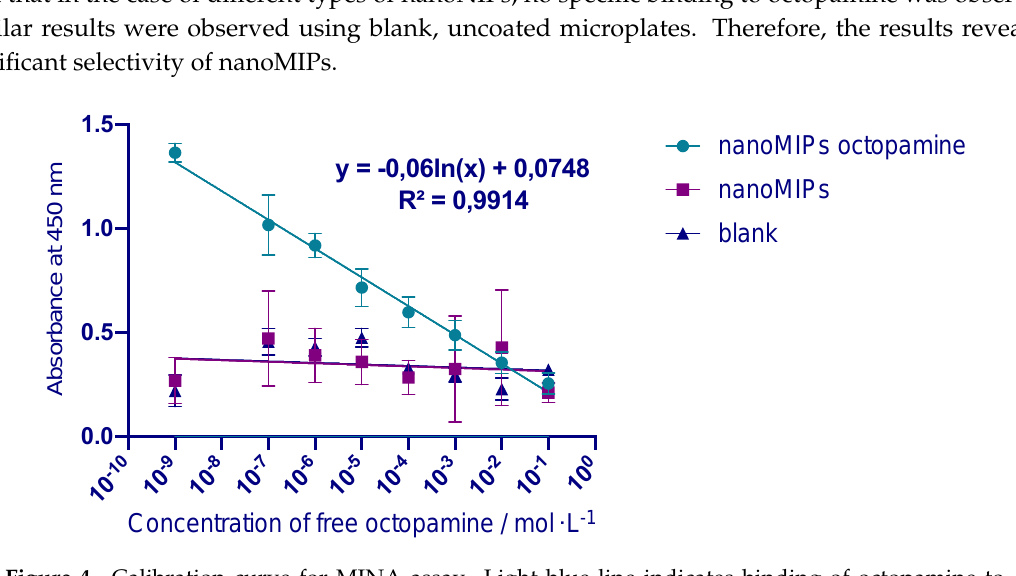
Figure 4. Calibration curve for MINA assay. Light blue line indicates binding of octopamine to octopamine specific nanoMIPs (circles). Purple line indicates binding of octopamine with labetalol specific nanoNIPs (squares). Dark blue line indicates binding of octopamine to blank, uncoated microplates. Error bars represent the standard deviation for experiments performed in triplicate.